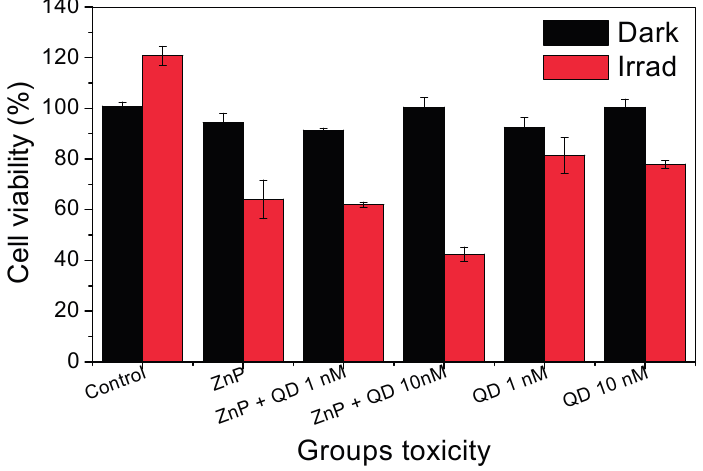
Figure 6. Measurement of cytotoxicity of fibroblasts cells treated with two different photosensitizers or their combinations: cells were exposed to (1) QDs (CdTe-MSA) in a concentration of 1 and 10 nmol·L − 1 ; (2) ZnP kept at 10 µmol·L − 1 and (3) QD/ZnP conjugates. All the systems were tested in the dark (dark shadow) or were irradiated at 460 nm (±20) 150 mW irradiation for 9 min (red shadow). The estimative of cytotoxicity was obtained by MTS test (data points show the mean standard deviation, n = 5). ANOVA results showed p < 0.05. All irradiated groups had a statistically significant difference compared to the non-irradiated